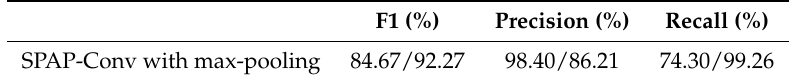
Table 5. Effectiveness of the SPAP-Conv with max pooling, where the two values b / m of each cell correspond to benign and malicious cases,